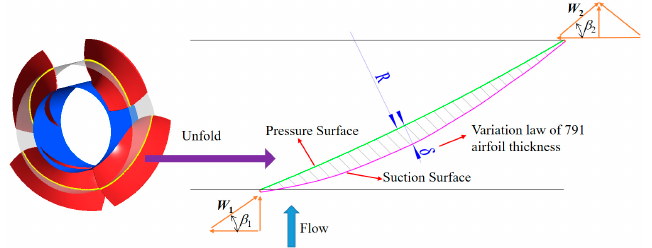
Figure 1. Schematic diagram of airfoil designed by circular arc method.